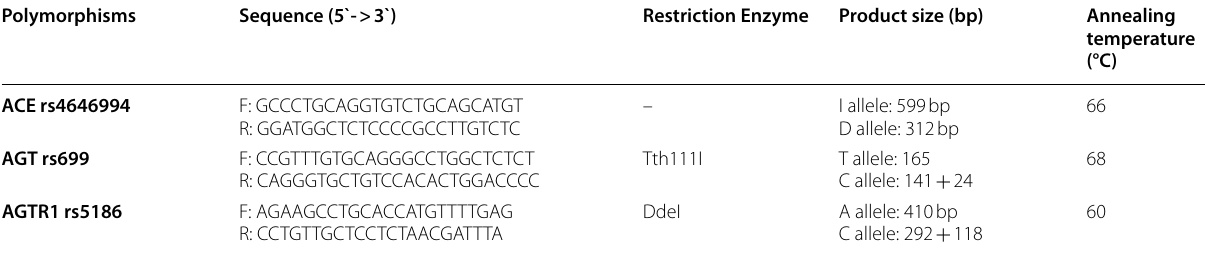
Table 1 Primer sequence used for detection of ACE rs4646994, AGT rs699 and AGTR1 rs5186 gene polymorphisms Polymorphisms